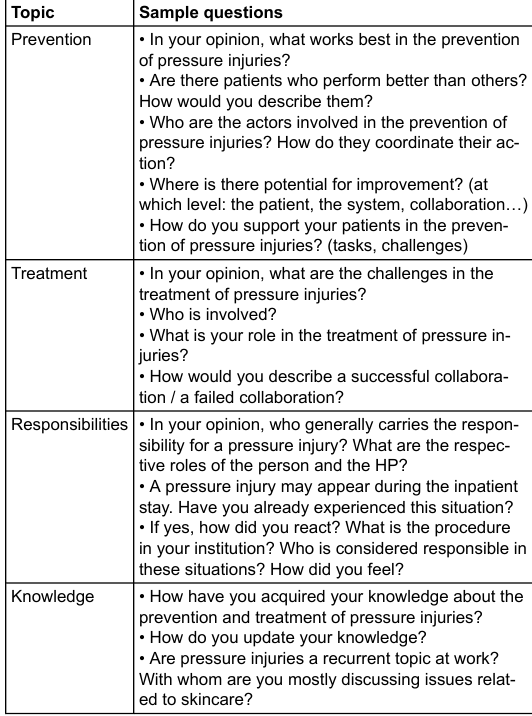
Table 1: Sample questions for the semi-structured